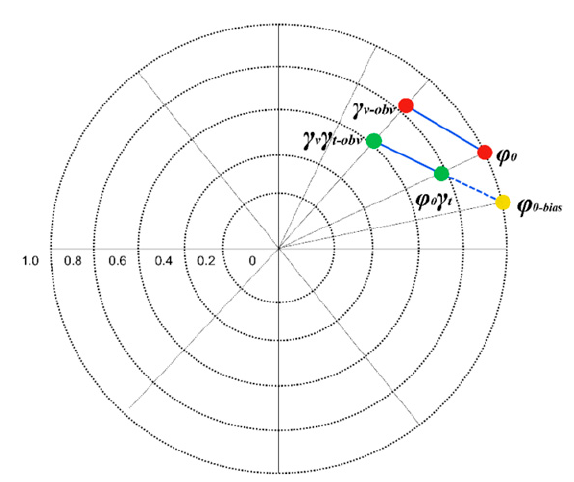
Figure 2. Plot illustrating the effect of temporal decorrelation on volume coherence and ground phase.